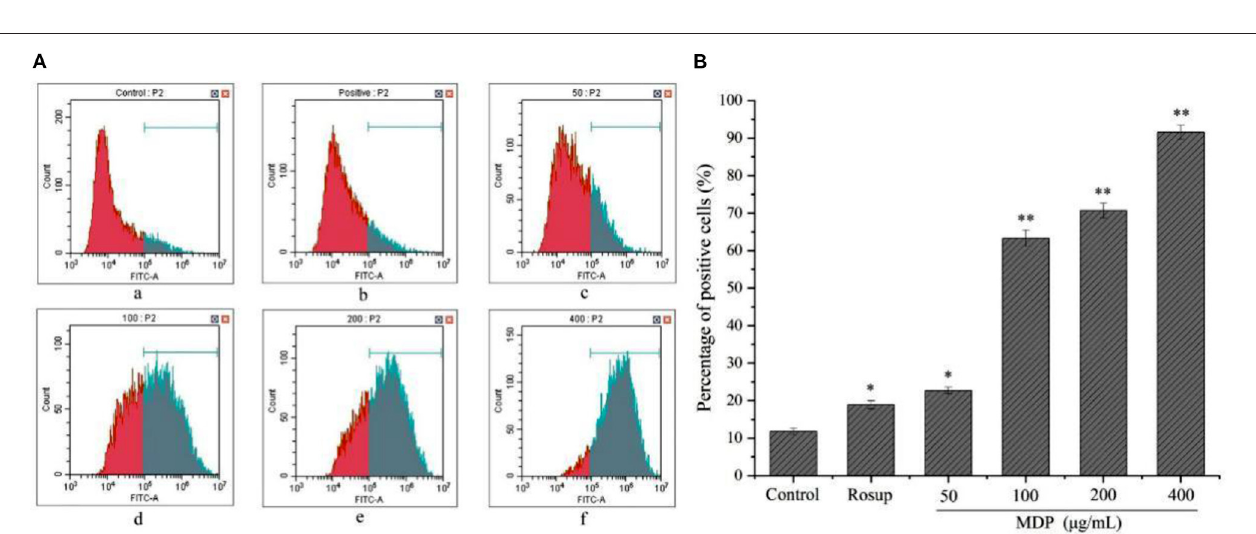
SD, n 3. * P < 0.05 or ** P < 0.01 vs. control group. ± =